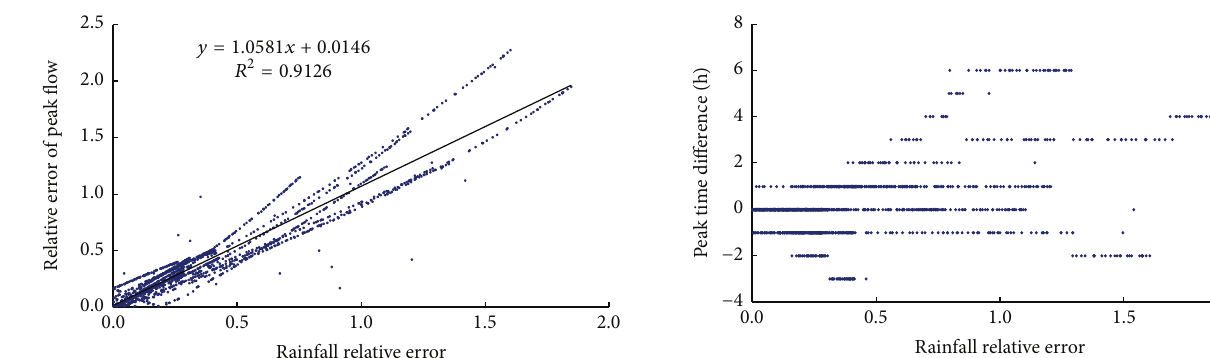
Figure 4: Relationship between relative error in predicted flood peak magnitude and rainfall relative error.